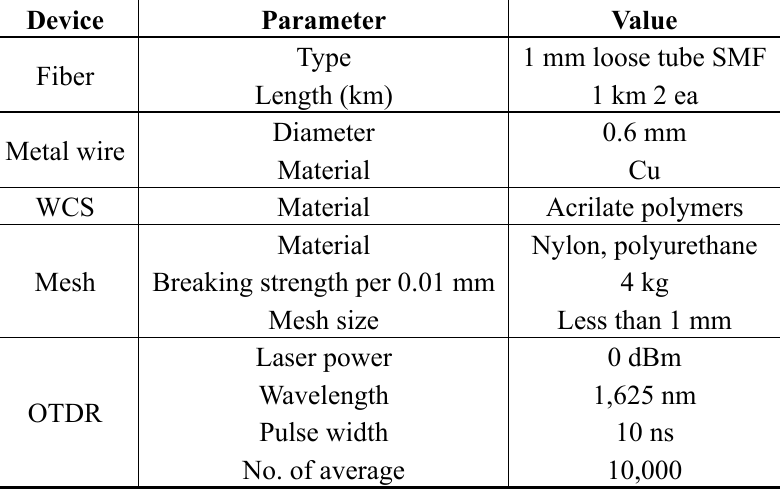
Table 1. Optical fiber and fiber optic sensor